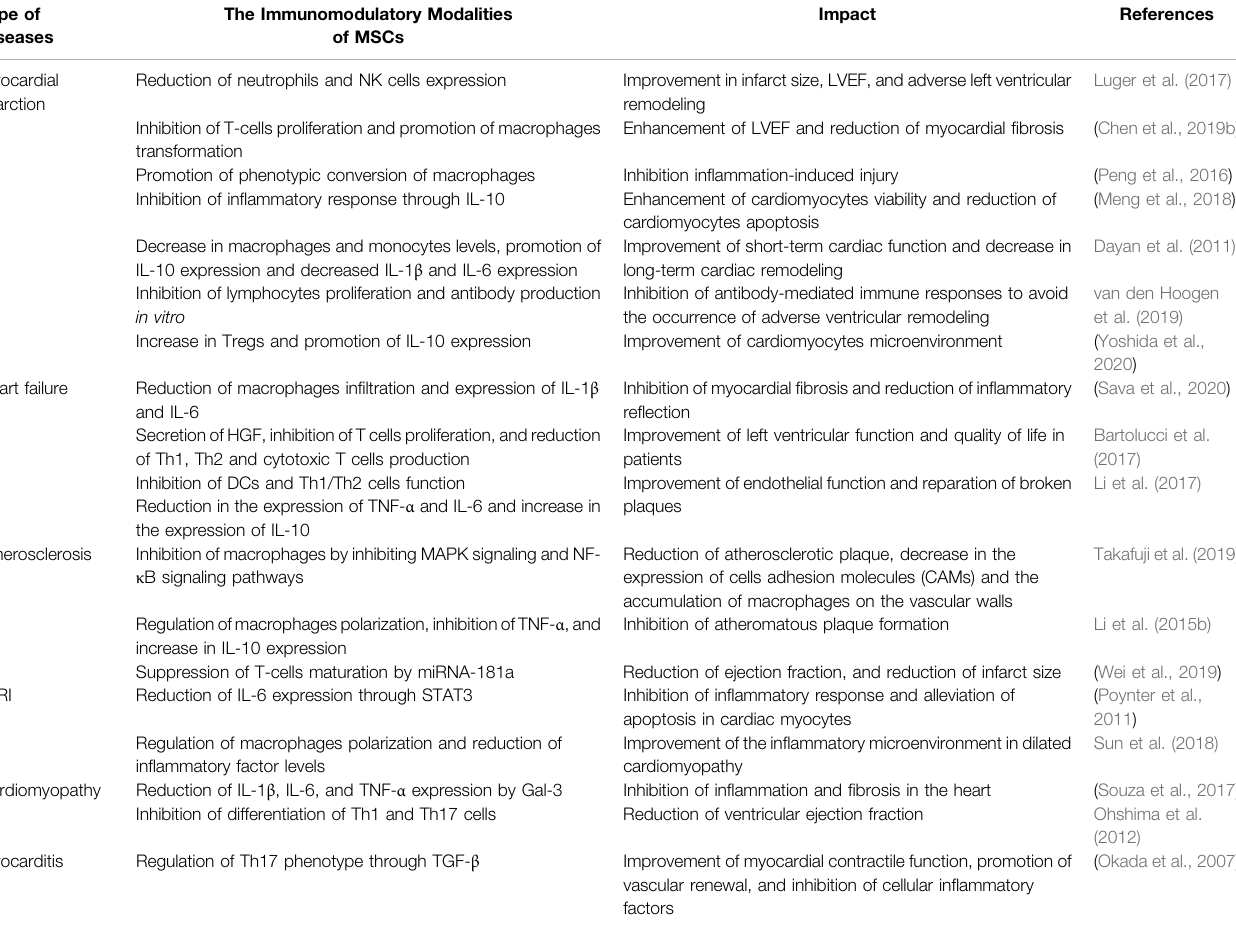
TABLE 2 | Immunomodulatory effect of MSCs in